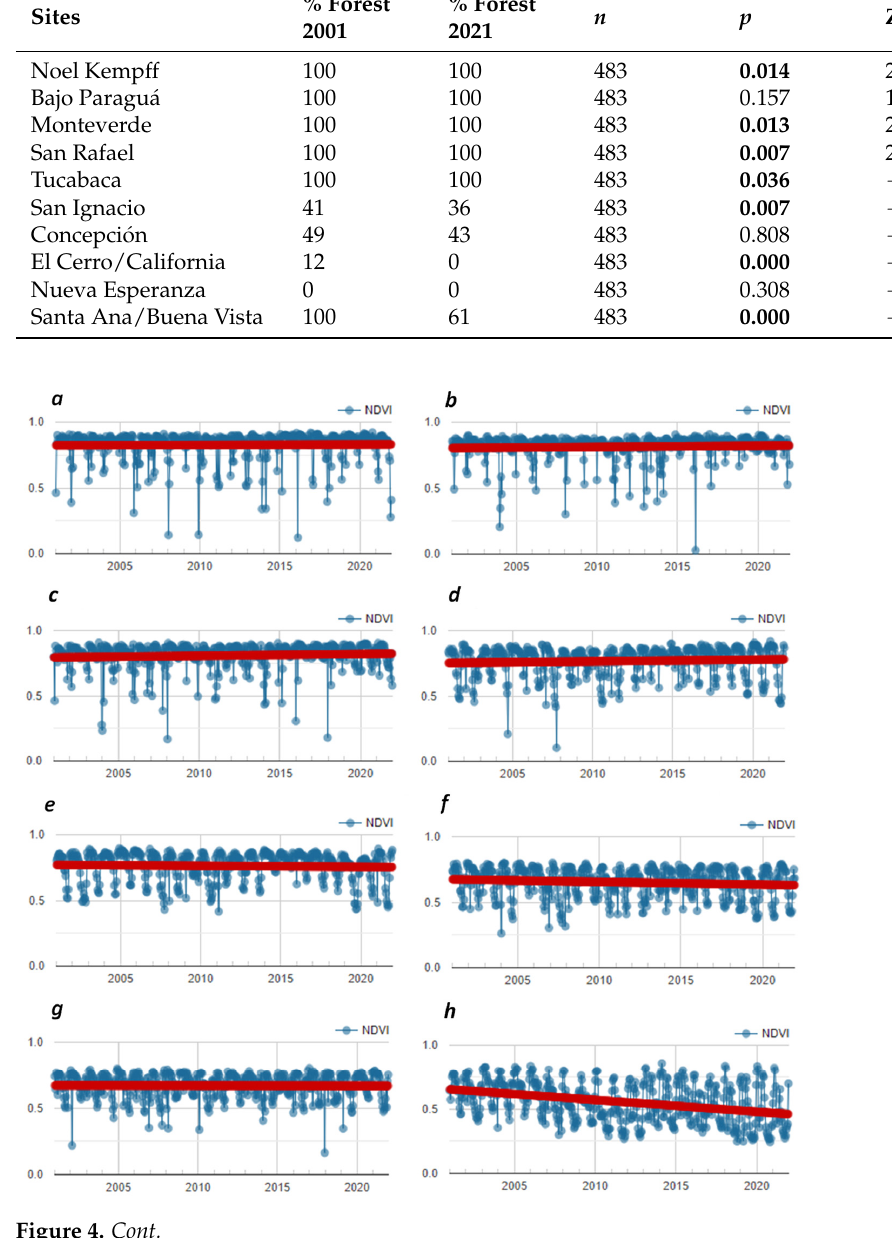
Figure 4. Trends in NDVI time series in forested and deforested areas in the Chiquitania region (2001-2021). The red line represents the trend line of the data points. Sites with intact forest : ( a ) Noel Kempff, ( b ) Bajo Paraguá, ( c ) Monteverde, ( d ) San Rafael, and ( e ) Tucabaca. Sites with deforestation: ( f ) San Ignacio, ( g ) Concepción, ( h ) El Cerro/California, ( i ) Nueva Esperanza, and ( j ) Santa Ana/Buena Vista. 3.3. Annual Trends in Land Surface Temperature (LST) Day and Night (°C) in Forested and Deforested Areas 3.3.1. Annual Averages of Daytime LST The annual averages of daytime LST (°C) obtained from the daily MODIS product MYD11A1 showed latitudinal variations in relation to the location of the sampling sites between northern and southern Chiquitania (Figure 5). The forests of Noel Kempff (27.0 ± 0.50 °C ), Monteverde (27.0 ± 0.45 °C), and Bajo Paraguá (26.6 ± 0.57 °C), located in the northern Chiquitania region, presented lower average temperatures than those in the southern region, specifically in San Rafael (28.1 ± 0.84 °C) and Tucabaca (29.3 ± 0.92 °C). Between forested areas, the daytime LST averages showed a difference of up to 2.7 °C.